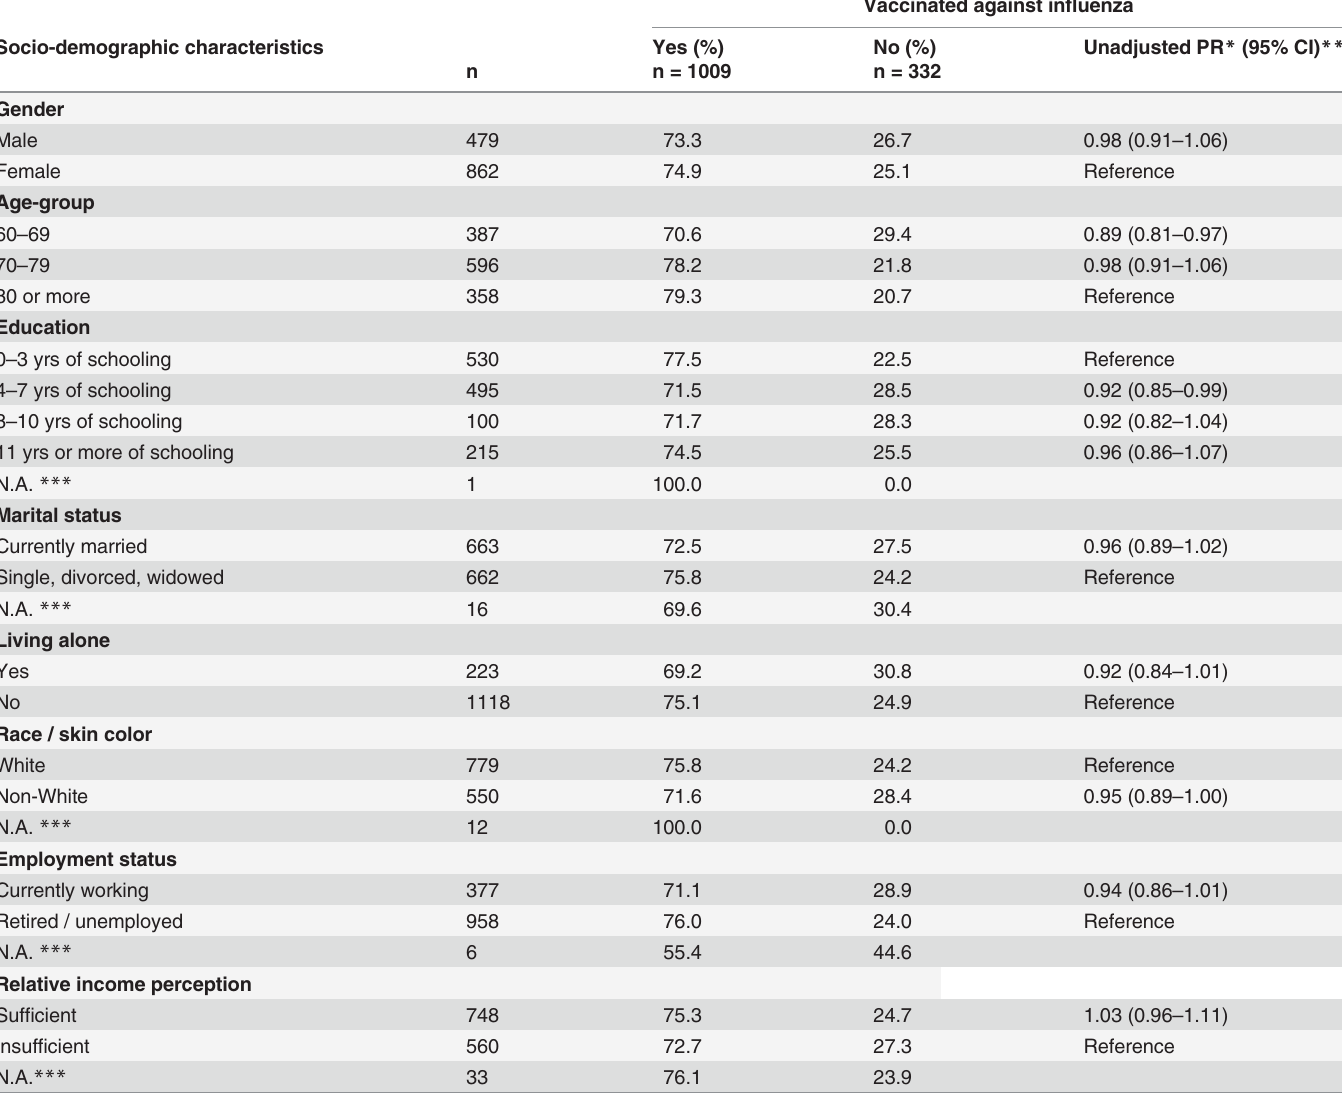
Table 1. Influenza vaccination among the elderly (n = 1,341) by socio-demographic characteristics. S ã o Paulo, Brazil,